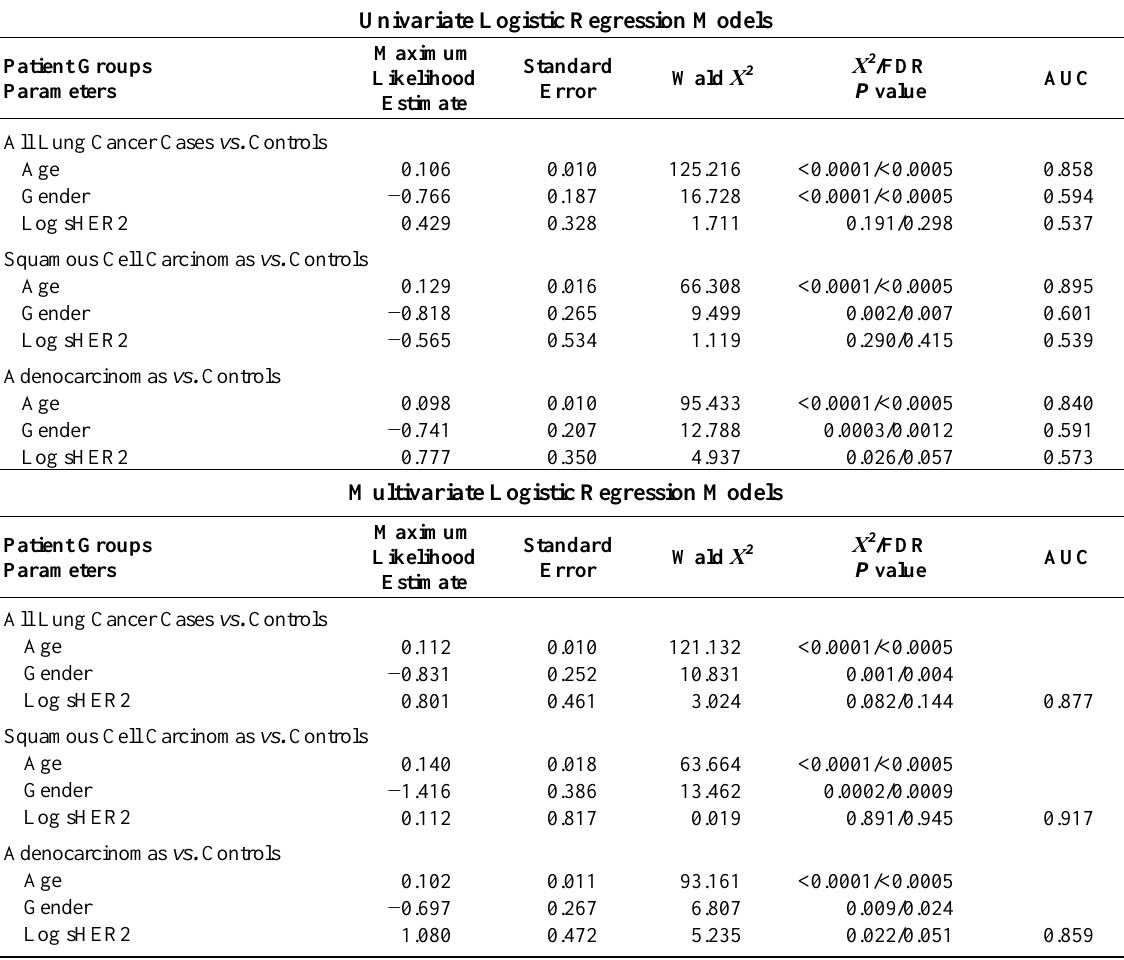
Table 4. Logistic regression models of non-small cell lung cancer (NSCLC) with age, gender, and log-transformed serum sHER2 concentrations as covariates. Univariate and multivariate logistic regression models are shown of men and women with lung cancer compared to healthy men and women ( i.e ., controls) for all lung cancer cases combined, and stratified by tumor histological subtype.